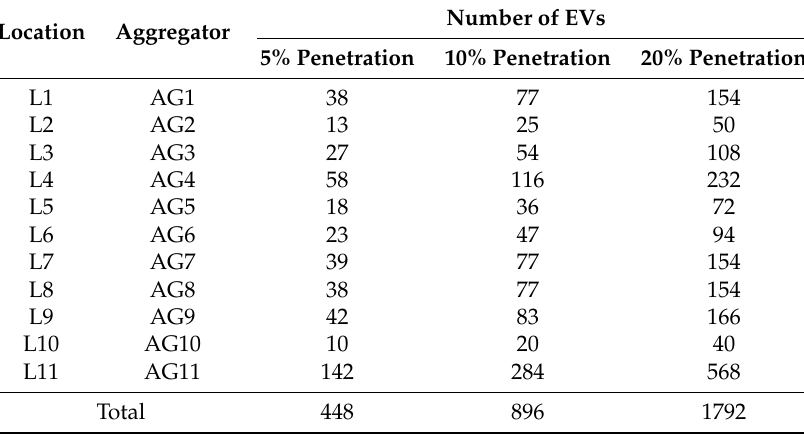
Table 3. Electric vehicle (EV) penetration levels in the